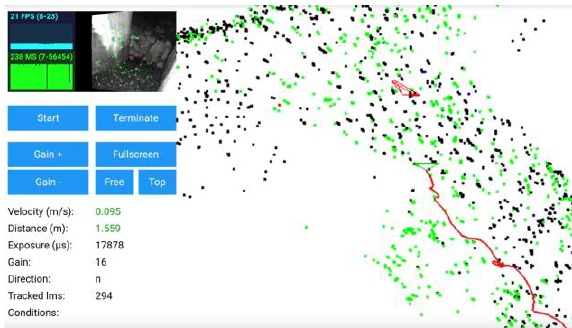
Figure 13 . Example of reuse of the map for 3D monitoring